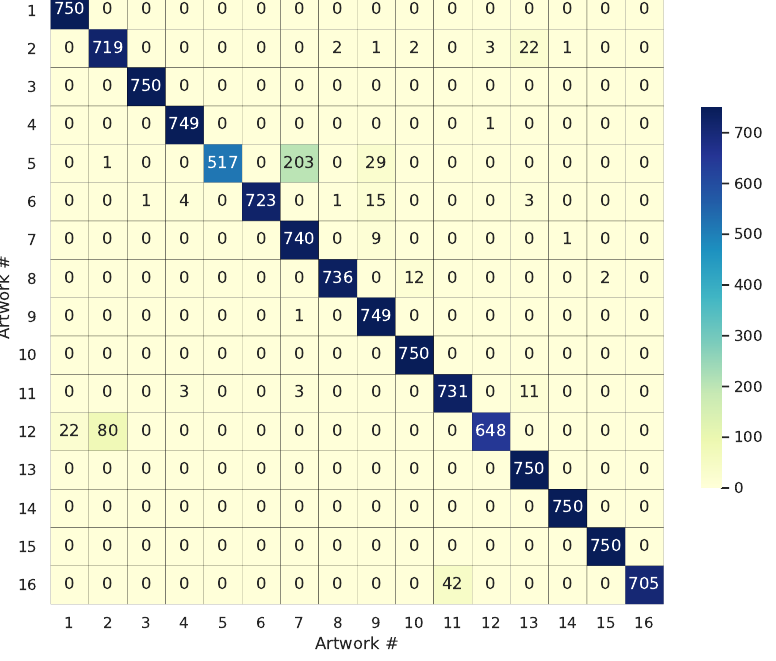
Figure 8. Confusion matrix for the predictions in data without occlusions and brightness intensity